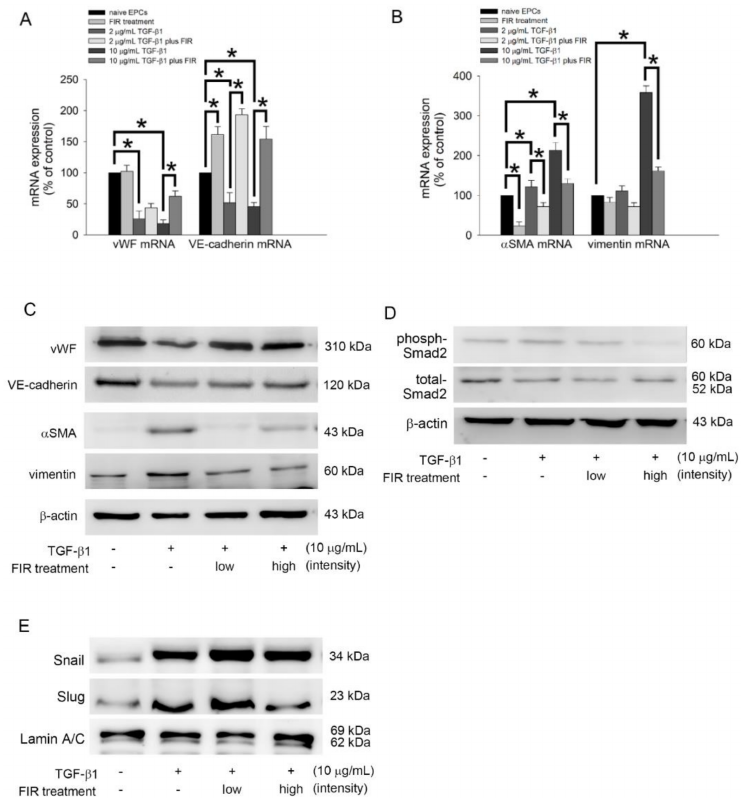
Figure 6. FIR treatment regulates TGF- β 1-induced EndoMT via Smad- and Slug-dependent pathways. ( A , B ) Human EPCs were exposed to 2 or 10 µ g/mL recombinant human TGF- β 1 for 5 days with high intensity or without FIR treatment. The α -SMA, VE-cadherin, vWF, and vimentin mRNA expression were evaluated using reverse transcription and qPCR analysis. The expression of related mRNA expression is normalized to the expression of GAPDH mRNA, is presented as a bar graph. All data are expressed as the mean ± SD of five independent experiments and as the percentage of the control. * p < 0.05 was taken into consideration statistically considerable. ( C , D ) Human EPCs were exposed to 10 µ g/mL TGF- β 1 for 5 days with low intensity, high intensity or without FIR treatment. The total protein expression of the vWF, VE-cadherin, α -SMA, vimentin, and phosphorylated Smad2 were identified by Western blot analysis. β -actin and total-Smad2 were used as loading controls. ( E ) Human EPCs were treated with 10 µ g/mL TGF- β 1 in the presence or absence of FIR treatment for 5 days. Total nuclear lysates were purified, and the levels of Snail and Slug were analyzed using Western blotting; lamin A/C was used as a loading